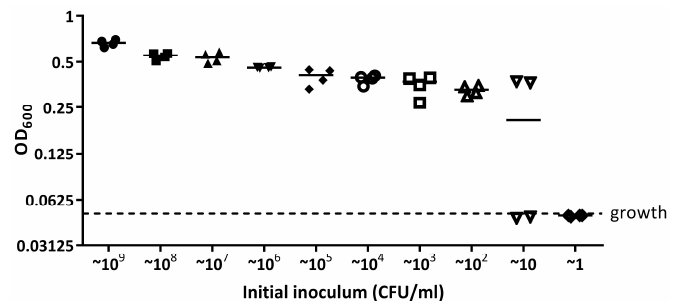
Figure A4. The limit of detection of S. aureus 6538 when grown in a 96 well plate. S. aureus 6538 was serially diluted in LB broth from ~10 9 CFU/mL to ~1 CFU/mL in a 96 well plate and incubated at 37 °C for 16 h. OD 600 was measured from each dilution and OD 600 readings above 0.05 are considered as growth. The data presented are from four independent experiments.